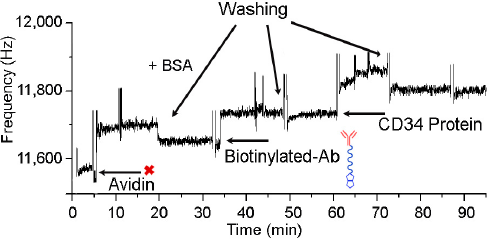
Figure 5. Frequency shift mesurements in the QCM immunosensor for the CD34 protein detection.